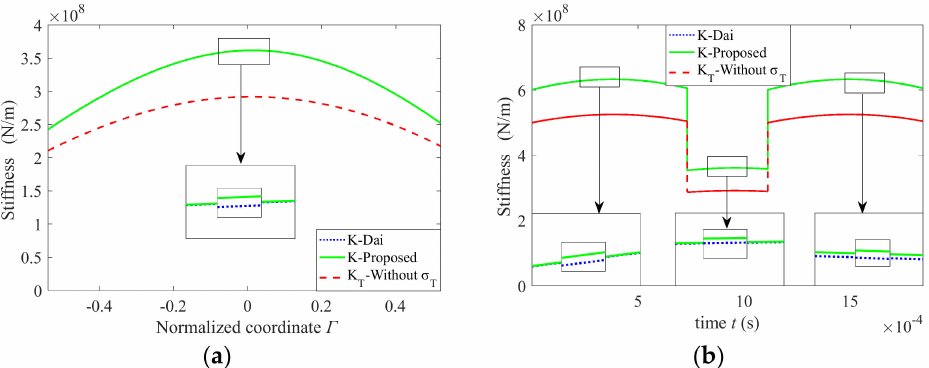
Figure 5. Gear thermal stiffness without considering thermal stress. ( a ) Mesh stiffness of a single pair of teeth; ( b ) Time-varying mesh stiffness of gears.